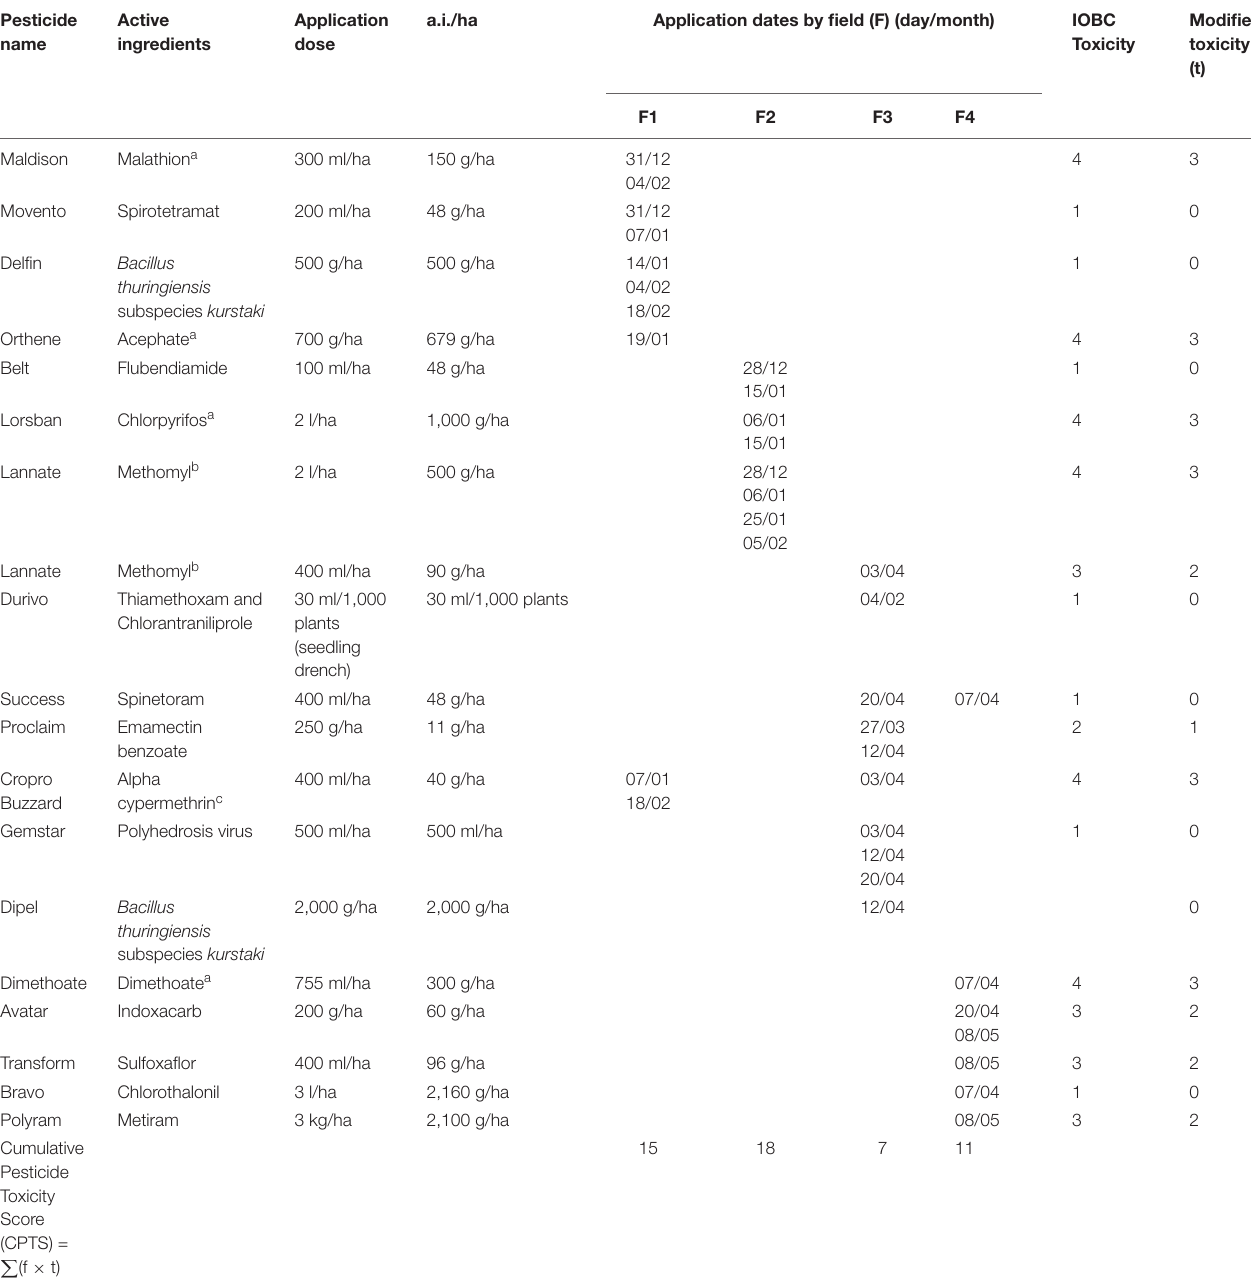
TABLE 1 | Insecticides and fungicides applied during the growing season (Dec 2016–May 2017) and the toxicity as determined by IOBC and modified toxicity rating for each site